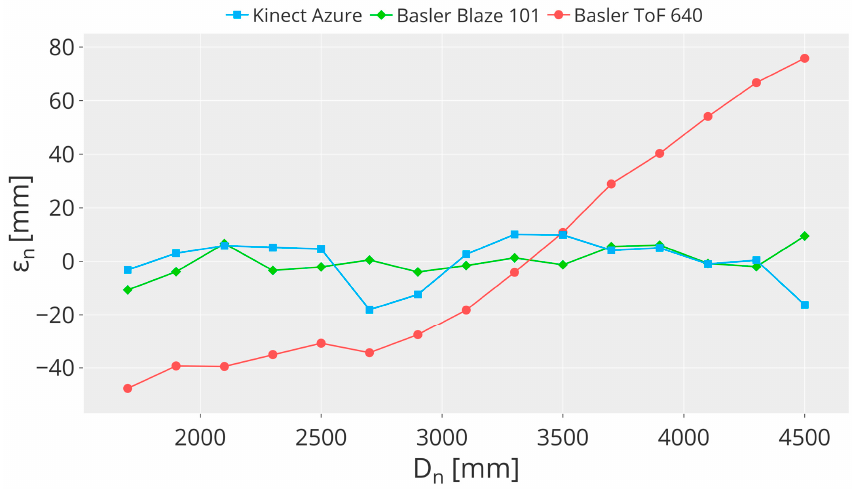
Figure 4. Plot showing the depth distortion error 𝜀 (cid:3041) computed for each camera for each 𝐷 (cid:3041)